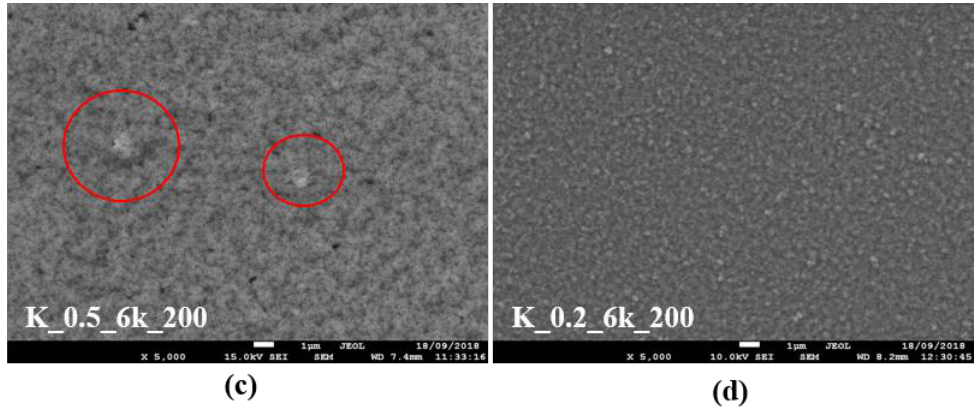
Figure 1. Surface of the Cu 2 ZnSnS 4 (CZTS) thin film: ( a , b ) optical microscopy and ( c , d ) scanning electron microscopy (SEM) prepared by using ink with concentrations of nanoparticles at 0.5 and 0.2 g / mL, respectively.